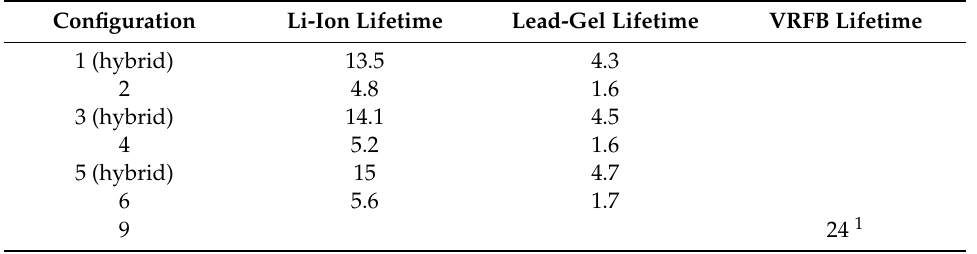
load profile. ind